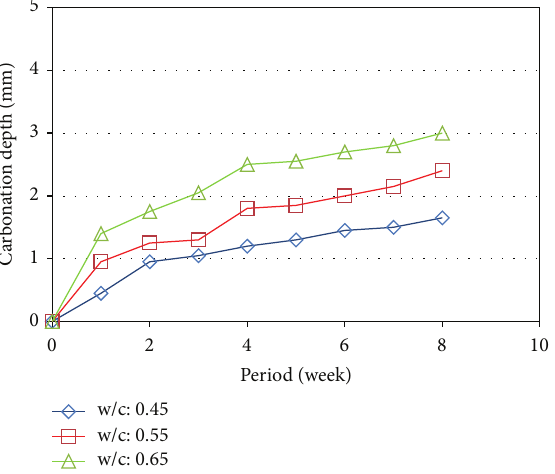
Table 4: Carbonation velocity.